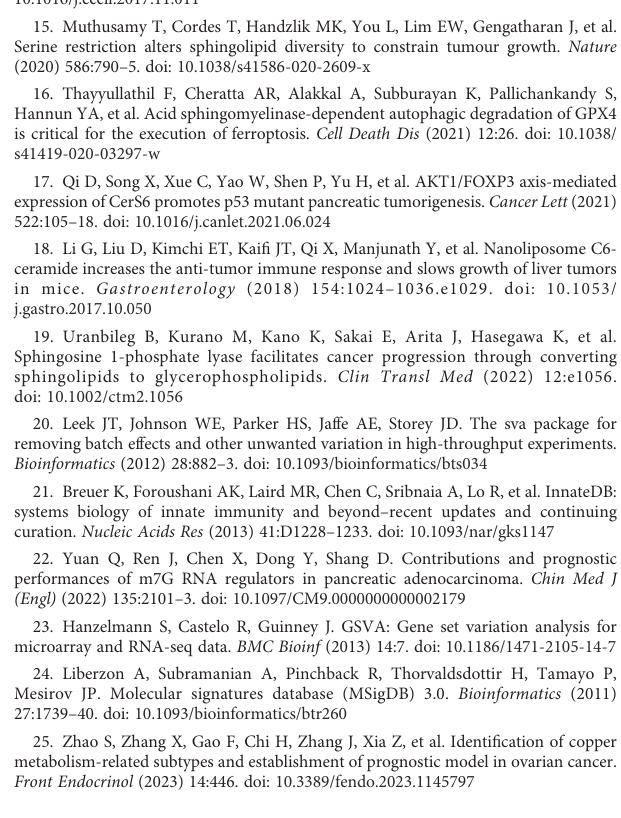
SUPPLEMENTARY FIGURE 1 Genes ’ Sequences of primers. SUPPLEMENTARY FIGURE 2 Immune in fi ltration in SPGcluster. SUPPLEMENTARY FIGURE 3 Immunotherapy prediction via 6-SPGs. (A) PRF survival between